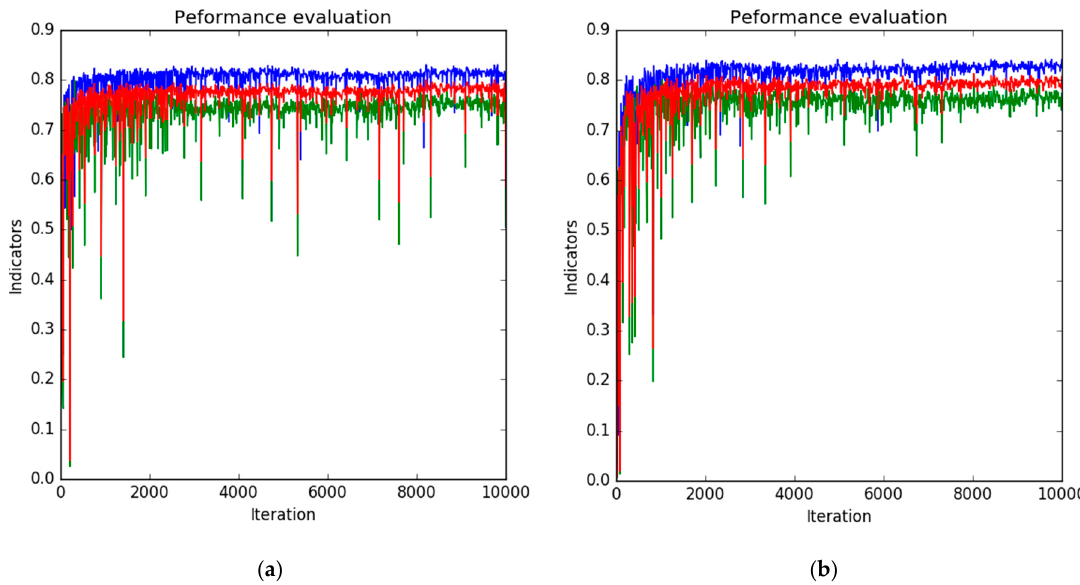
Figure 13. Validation curve of methods in Section 4.7: ( a ) without reconstruction, ( b ) with reconstruction. Blue, green, and red lines represent F1, AP, and mean of F1 and AP, respectively.